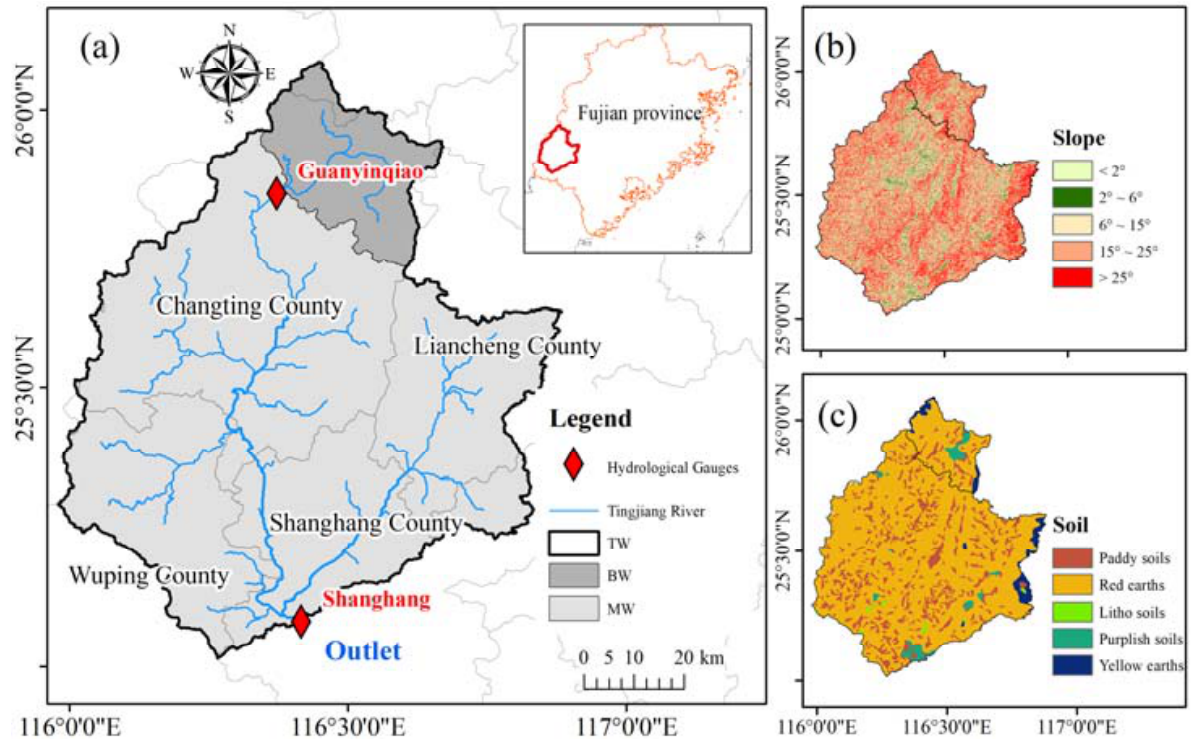
Figure 1. Location of the Tingjiang River Watershed (BW, MW, and TW) in Fujian Province and two hydrological stations ( a ), the slope ( b ) and the soil type ( c ) of the Tingjiang River Watershed.